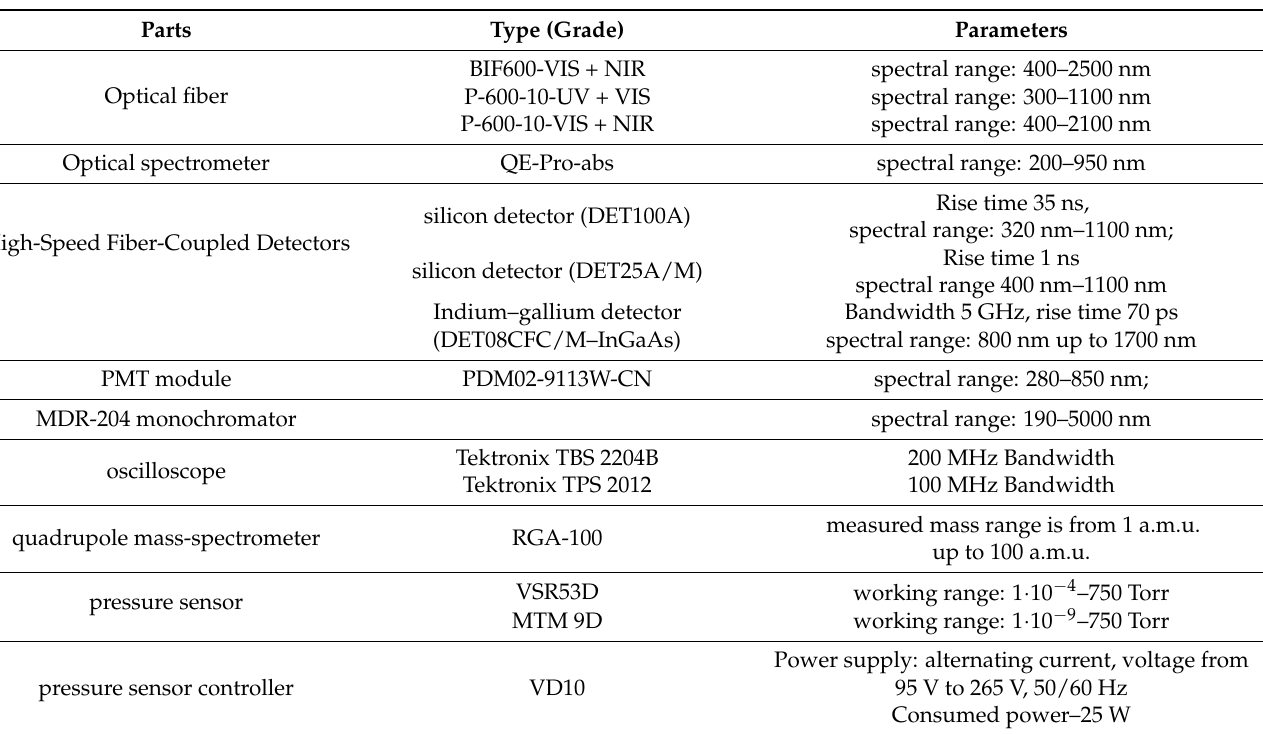
Table 2. Parts of the experimental facility IMS.